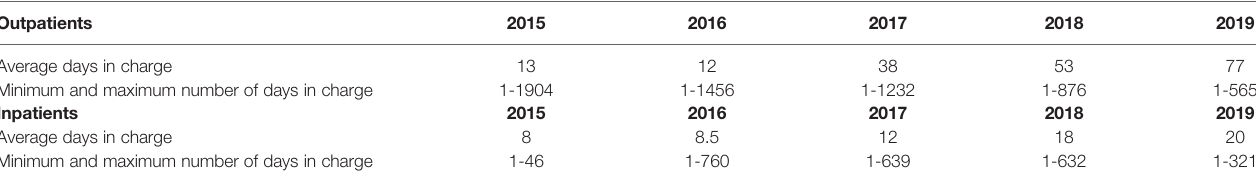
TABLE 2 | Analysis of days in charge of the